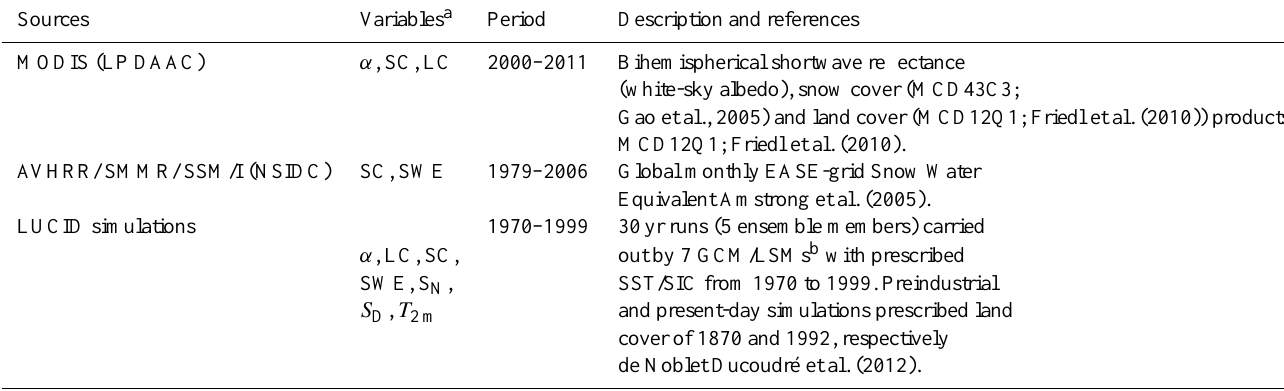
Table 1. Dataset